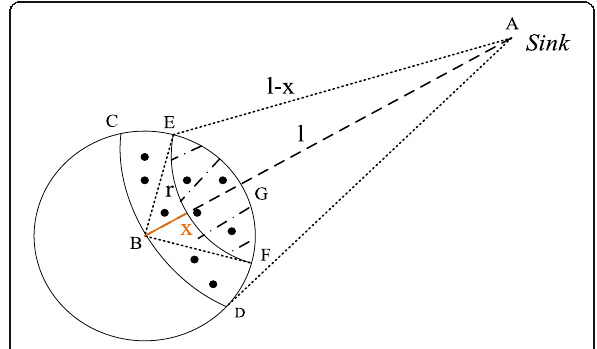
Fig. 4 Optional range of forwarder set after re-screening